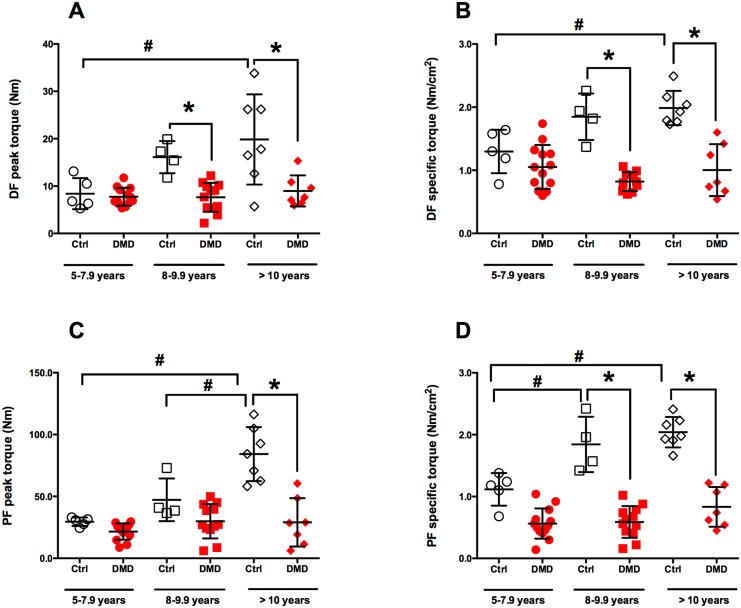
Comparison of dorsiflexors (DF) and plantarflexors (PF) peak torque (A, B) and specific torque in boys with DMD and healthy Ctrl across different age groups.* represents significant differences between DMD and Ctrl within age groups (p<0.05), # represents significant differences across the age groups (p<0.05). Data is presented as mean (SD).